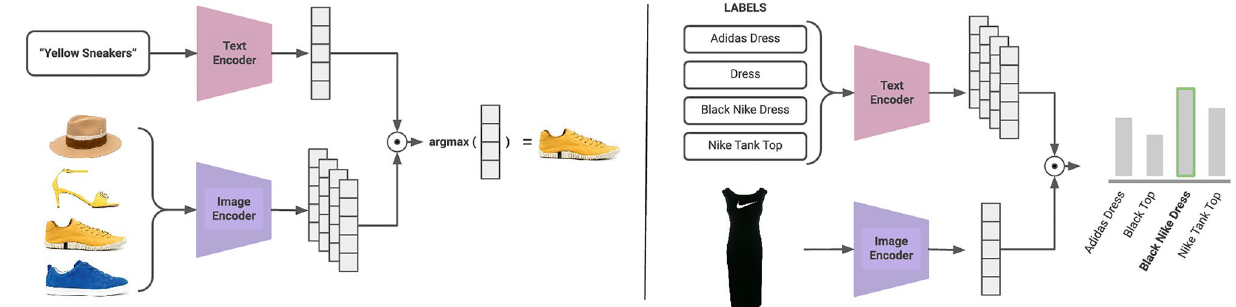
Figure 2. Schematic overview of multi-modal retrieval (left) and zero-shot classification tasks (right).